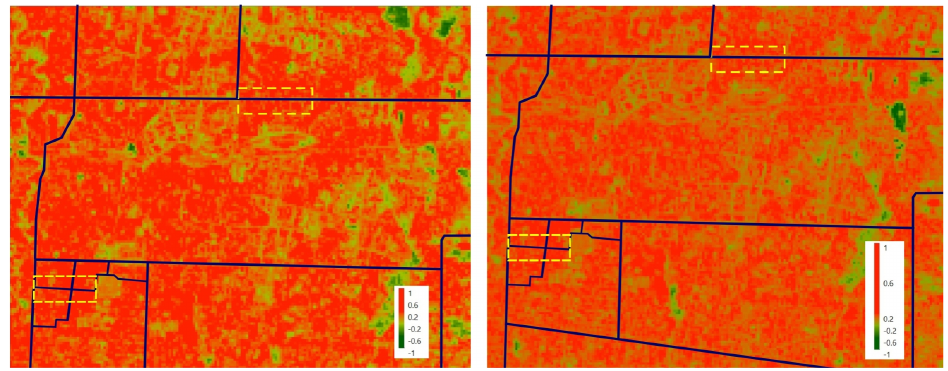
Fig. 9. NDVI maps retrieved from Landsat-8 OLI TIRS on May 5 at 02:47:15 (left) and August 25 at 21:50:13 (right).